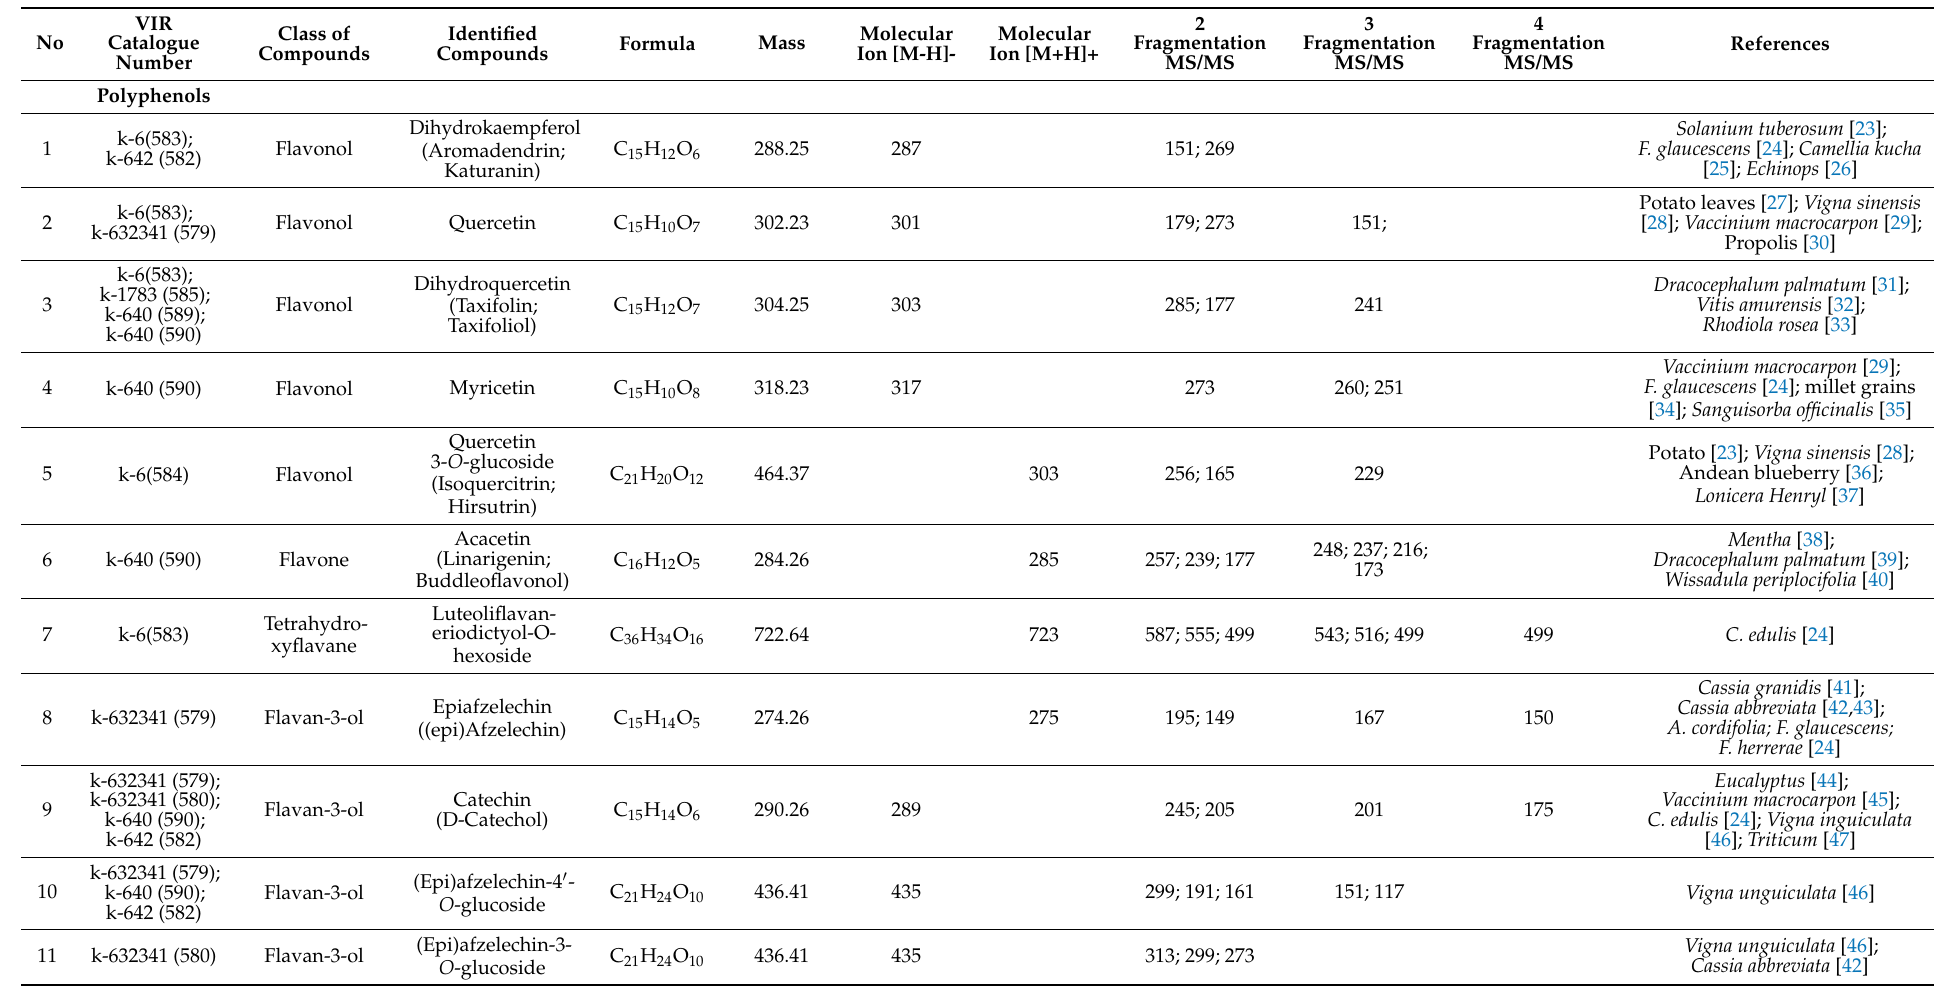
Table 2. Compounds identified from extracts of V. unguiculata under positive and negative ionization modes by tandem mass